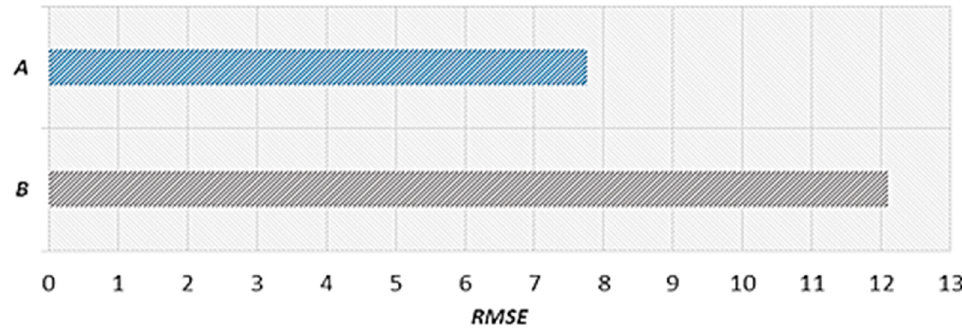
Figure 16. RMSE value considering the historical average speed. (A) average RMSE considering the historical average speed. (B) average RMSE without considering the historical average speed.